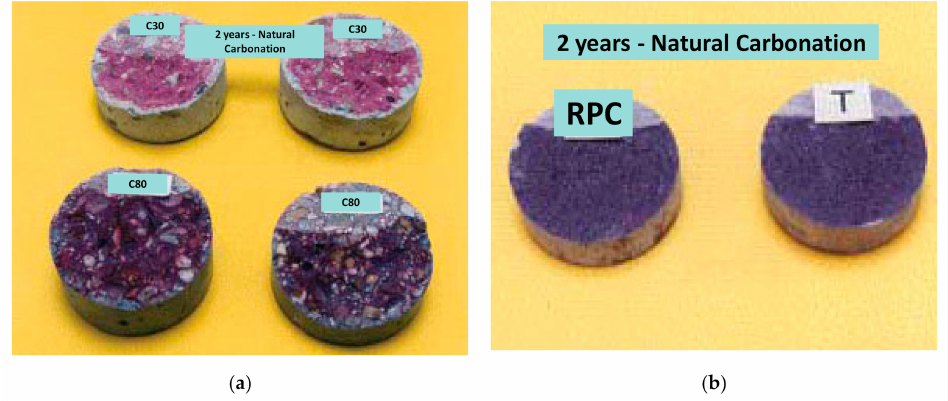
Figure 3. Two years natural carbonation depth results of concretes: ( a ) C30 and C80; ( b ) RPC200. Four high strength concretes named A, B, C, and D, with 28-day compressive strengths of 192 MPa, 138 MPa, 127 MPa, and 123 MPa, and made with the same constituents (CEM I 52.5 R, siliceous aggregates, and a high range water reducer) were tested for natural